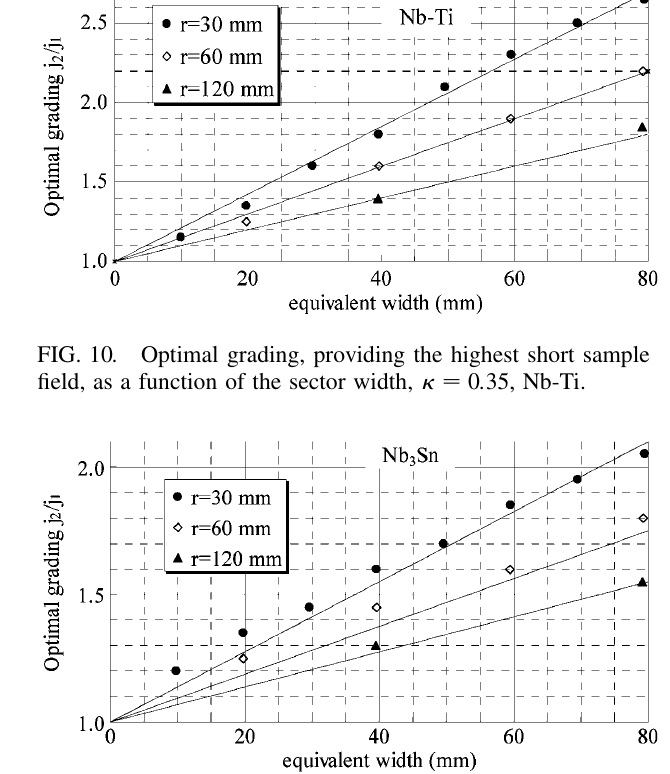
FIG. 9. (Color) Short sample field versus equivalent sector width for an aperture radius of 30 mm, Nb-Ti and Nb versus nongraded coils.